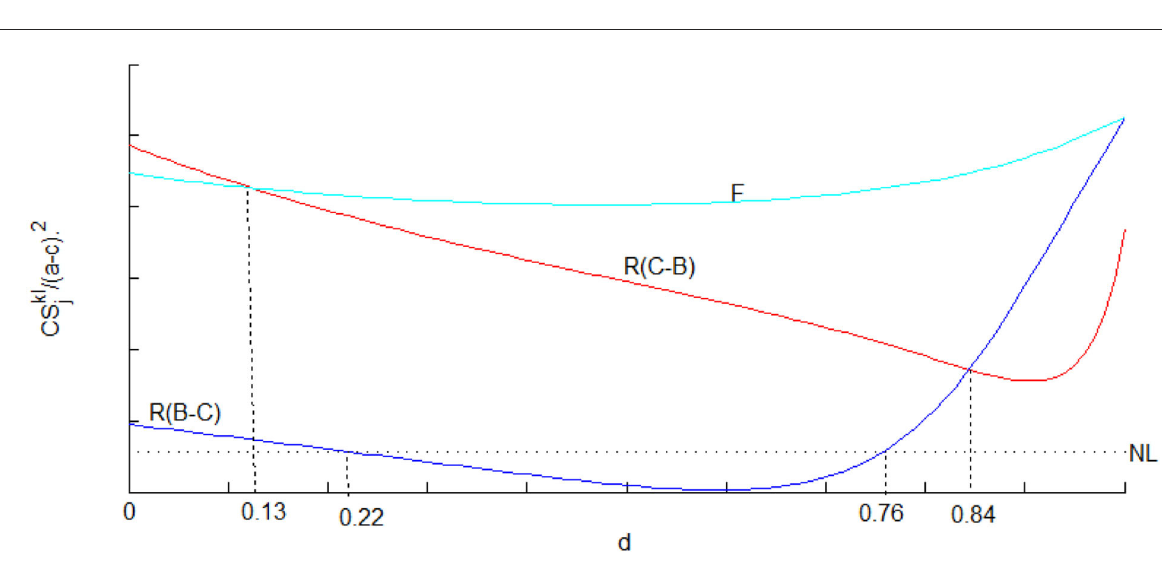
FIGURE3 Consumer surplus in different licensing methods under mixed